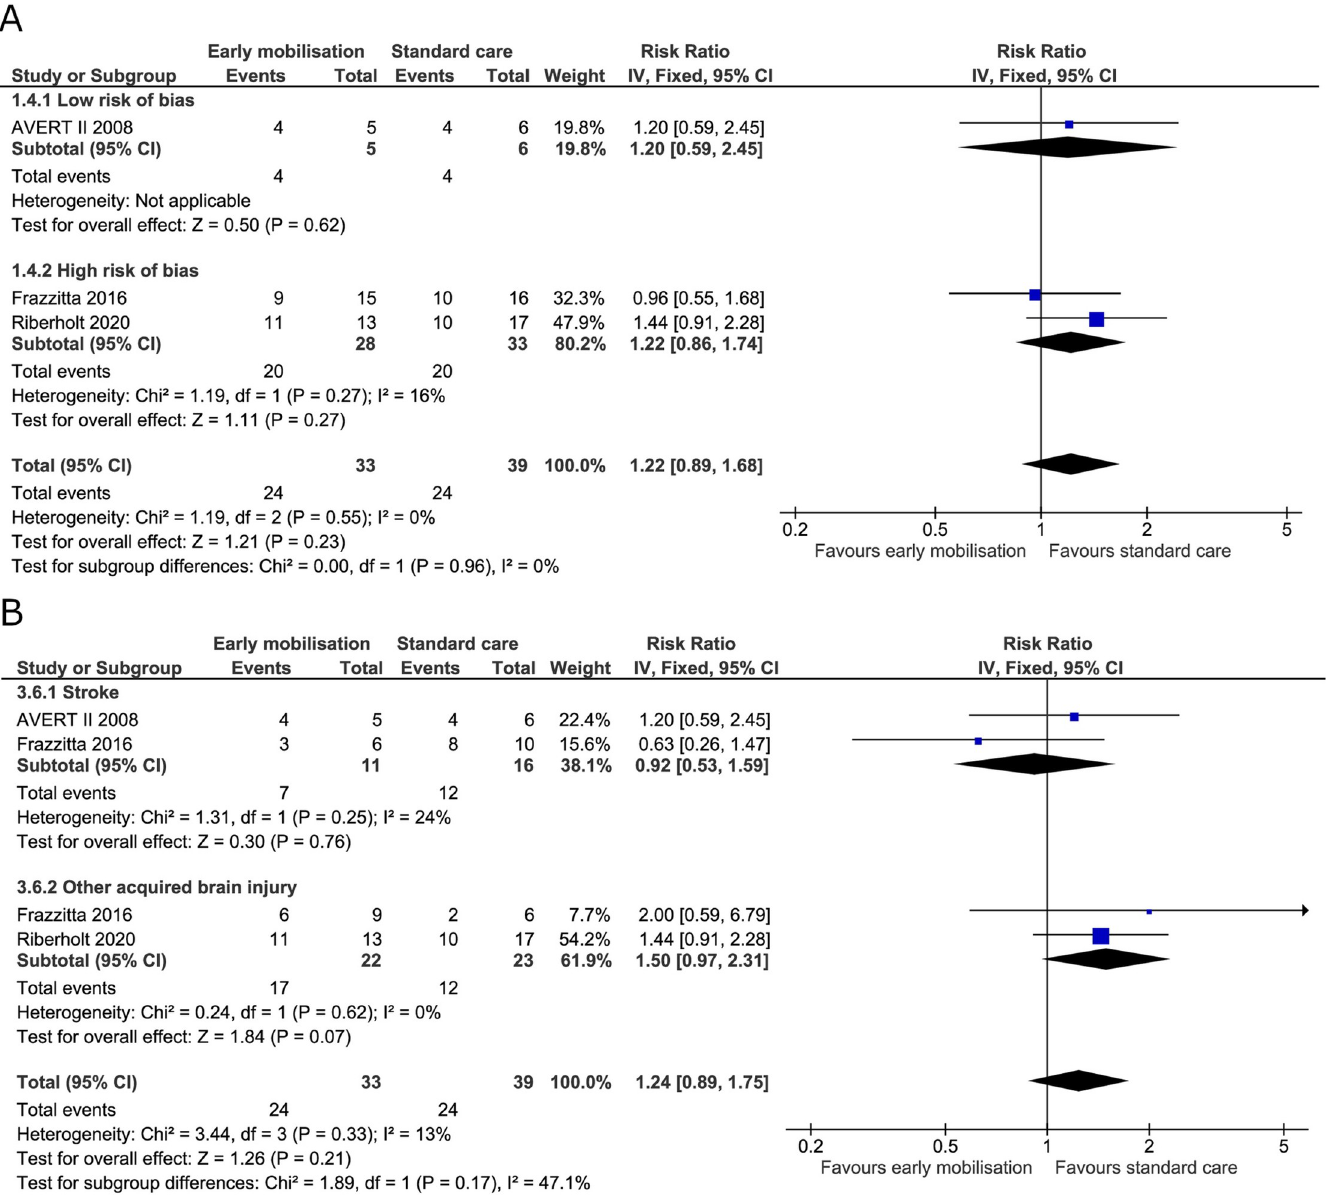
Fig 8. Comparison of early mobilisation versus standard care–Poor functional outcome among survivors at the end of the intervention. Fig 8A and 8B. Forest- plots showing the results from the fixed-effect meta-analysis of the outcome poor function at the end of intervention with subgroup divided according to risk of bias (A) or diagnosis